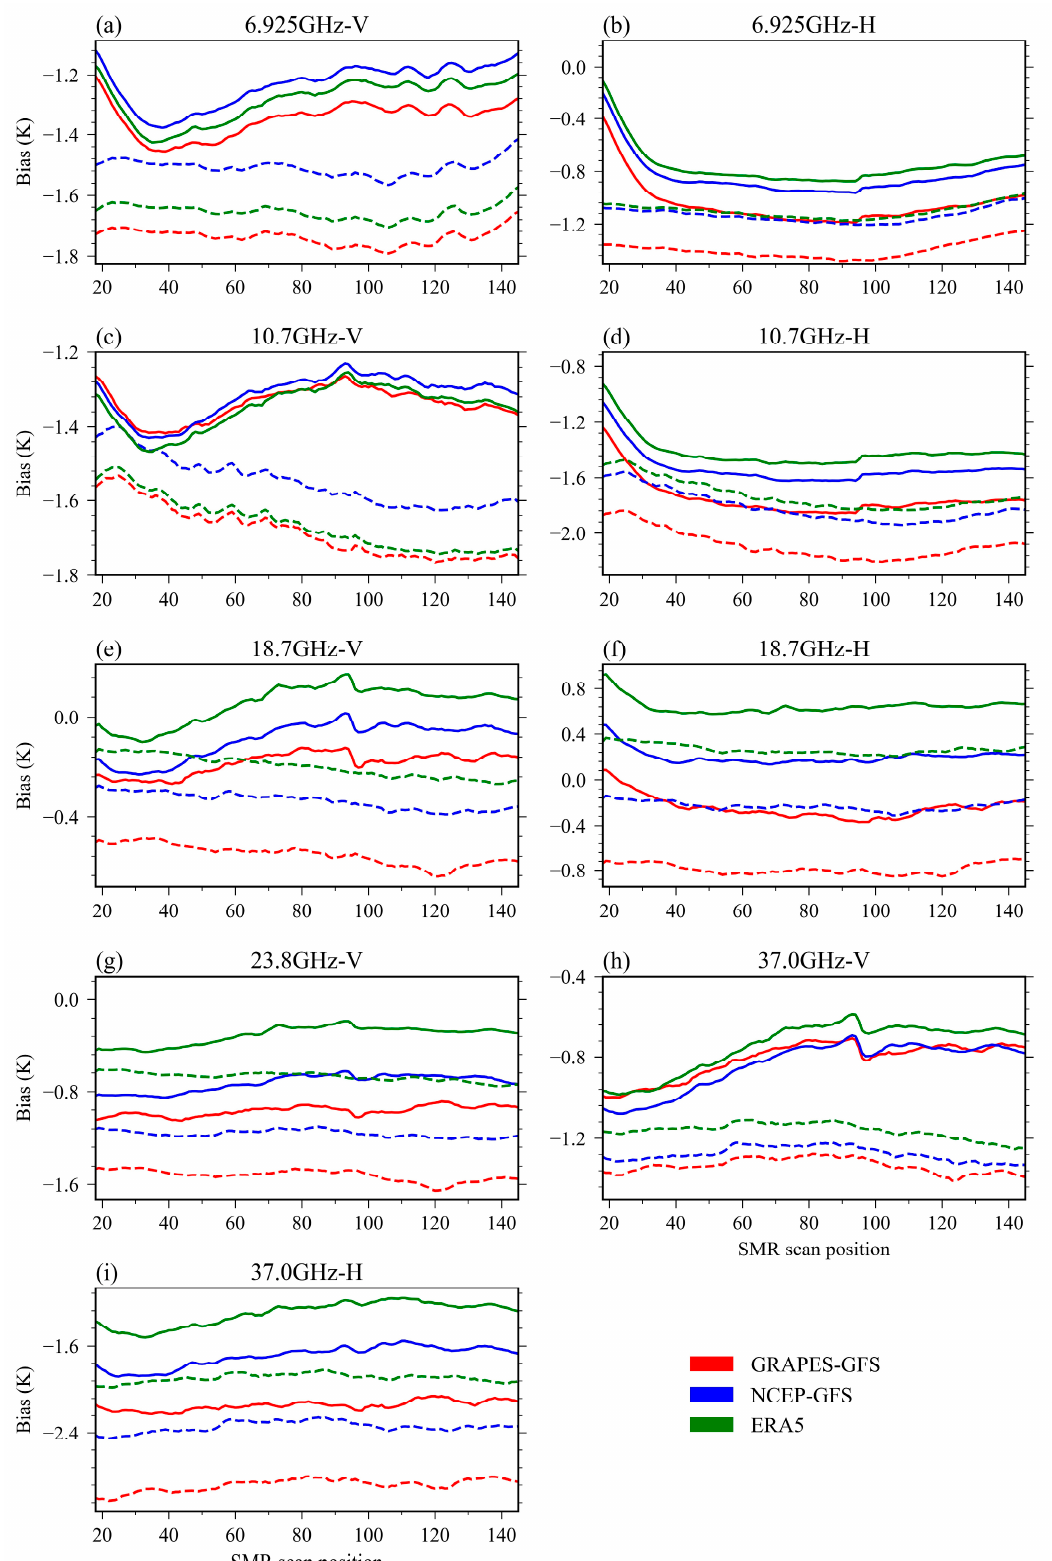
Figure 14. Variations in the average of O-B with the scan positions for each channel (solid line: as- cending data; dashed line: descending data). All statistics are given after applying the QC procedures described in Section 2.4.